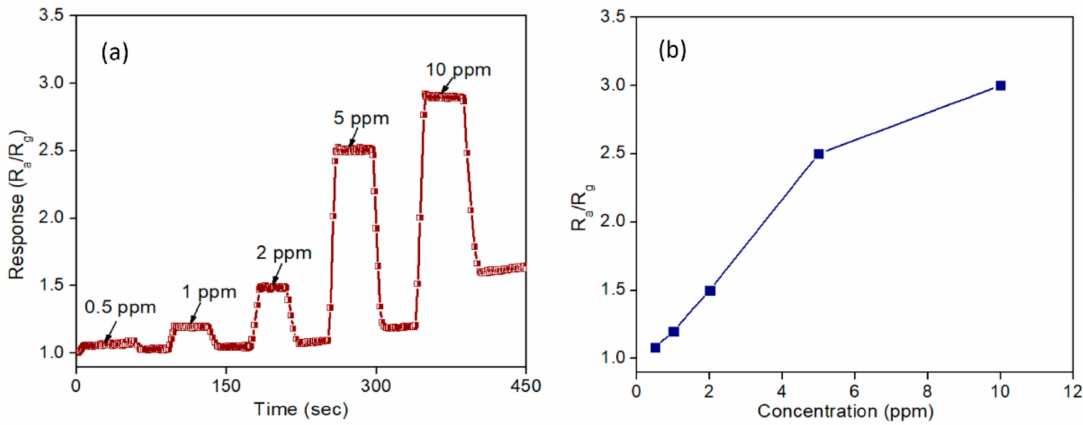
Figure 15. ZnO sensor response to ammonia gas in function of: ( a ) time and different gas concentra- tion; ( b ) gas concentration. Reprinted from Ref. [161] with permission of Elsevier Ltd.,